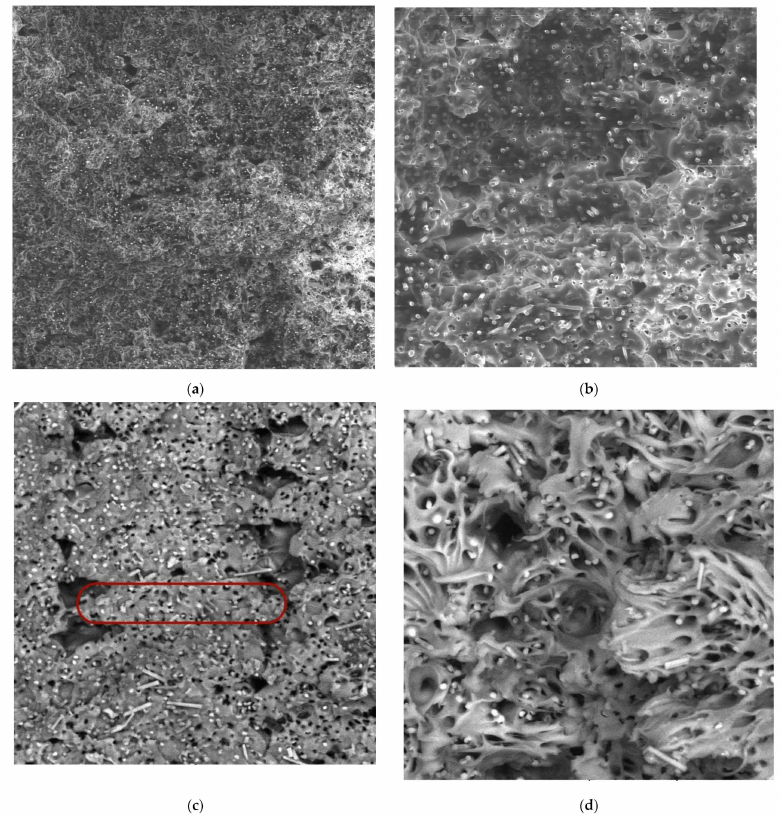
Figure 20. SEM images of fractured specimen zeta: ( a ) 100 × magnification, detector LVSD; ( b ) 300 × magnification, detector LVSD; ( c ) 300 × magnification, detector BSE, the red box presents one filament; ( d ) 500 × magnification, detector